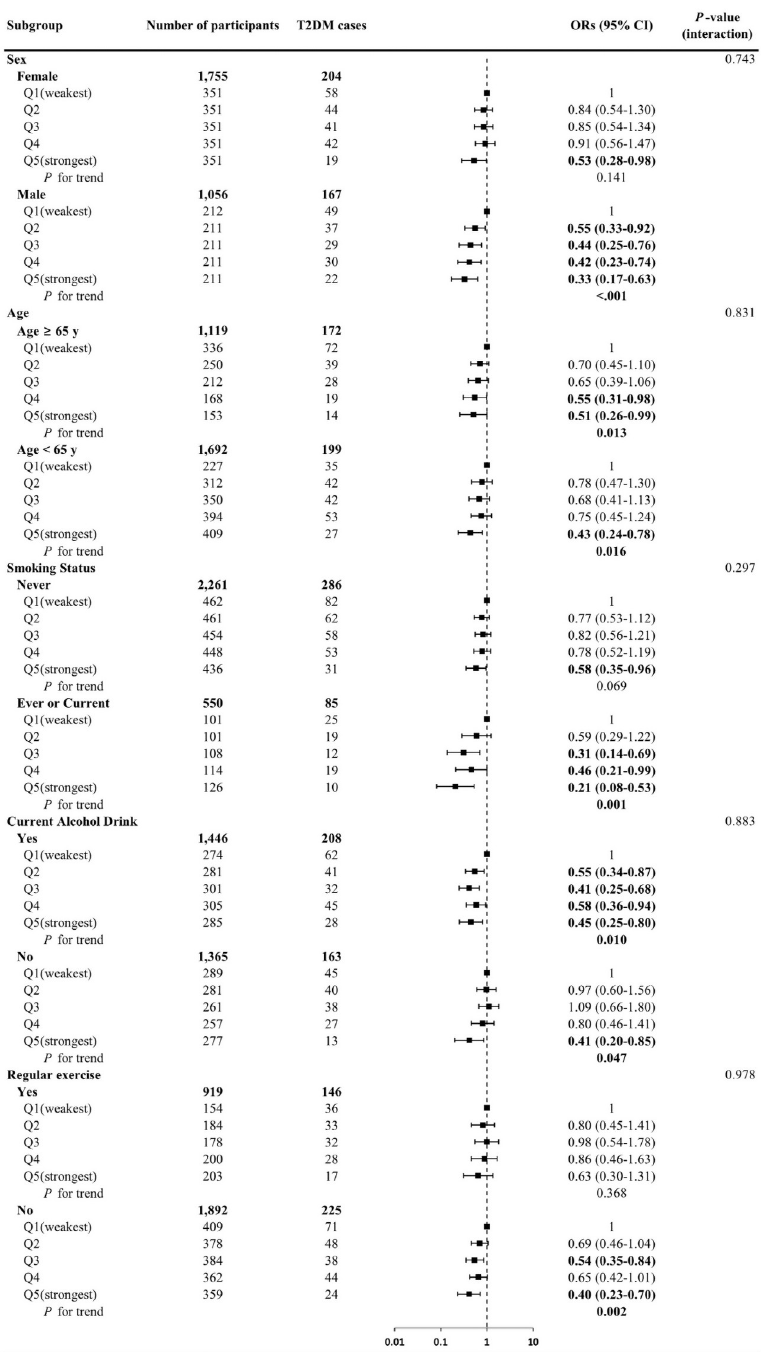
Fig 1. Odds ratios of T2DM by relative grip strength in stratified subgroup analyses. Data presented as adjusted odds ratios (95% confidence intervals) across the quintiles of relative grip strength. Analyses were adjusted for sex (not in sex-stratified analyses), age (years, not in age-stratified analyses), smoking status (never, former, or current, not in smoking-stratified analyses), current alcohol drinking (yes or no, not in alcohol-stratified analyses), regular exercise (yes or no, not in regular exercise-stratified analyses), living with family (yes or no), � high school graduate (yes or no), family history of diabetes (yes or no), hypertension (yes or no), dyslipidemia (yes or no), and body mass index (kg/m 2 ).